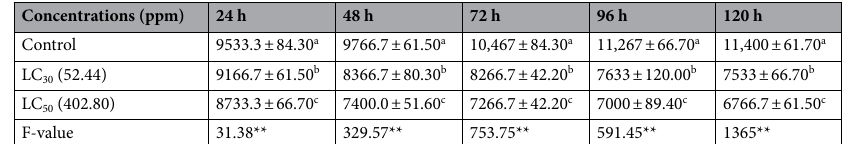
Table 6. Effect of gallic acid on total hemocyte count (Total number of hemocytes/mm 3 ) of S. litura larvae. **Significant at 1%. Values are Mean ± SE. Means followed by different superscript letters within a column are significantly different ( p ≤ 0.05) based on Tukey’s test.